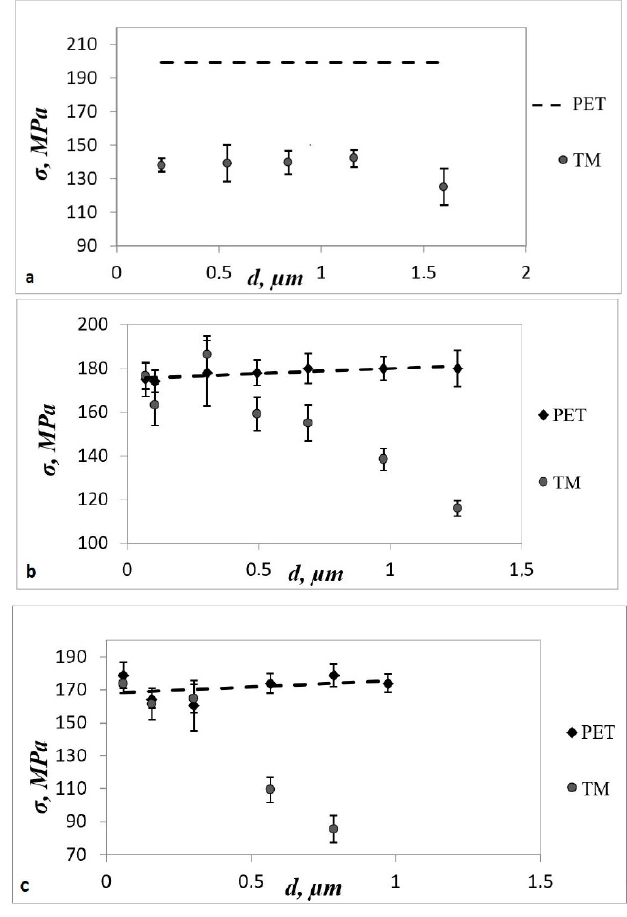
Figure 3. Dependence of strength on pore diameter for TMs with different densities: ( a ) n = 4 × 10 6 cm − 2 ; ( b ) n = 1.18 × 10 7 cm − 2 ; and ( c ) n = 4.41 × 10 7 cm − 2 . The dotted line on all plots corresponds to the unirradiated PET sample (without pores). For ( b , c ), it was considered that the film had passed the same etching mode as the TM with this diameter value. Table 4. Relative (expressed in diameters) mean distances between pore centers for TMs with n = 4 × 10 6 cm − 2 and different